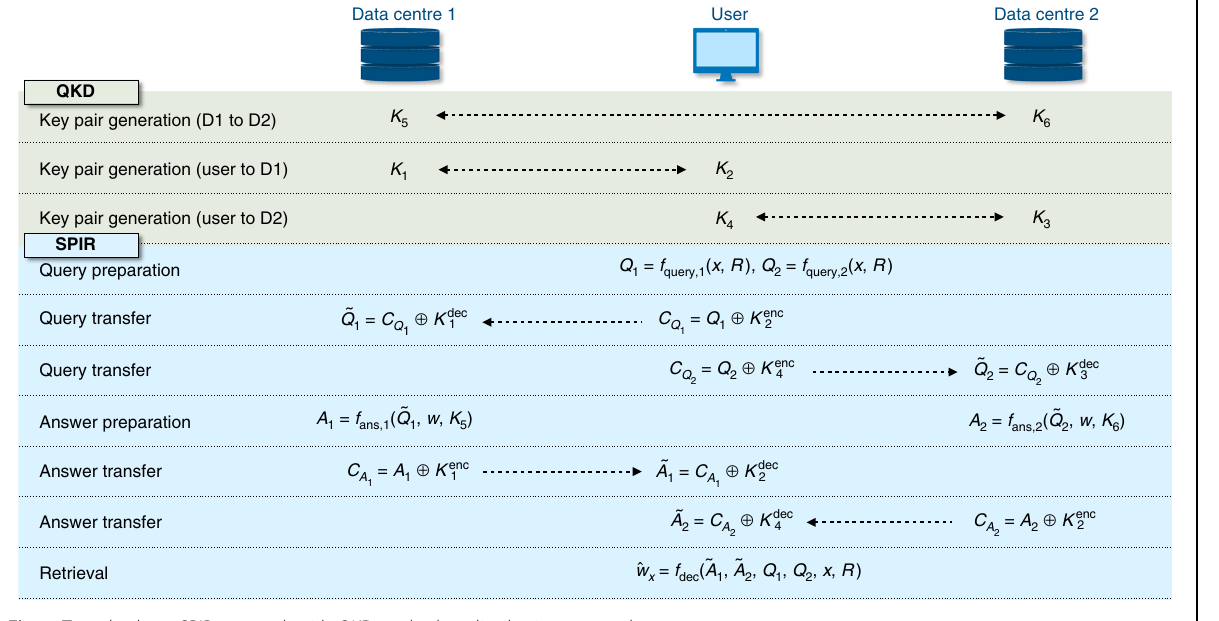
Fig. 1 Two-database SPIR protocol, with QKD as the key distribution